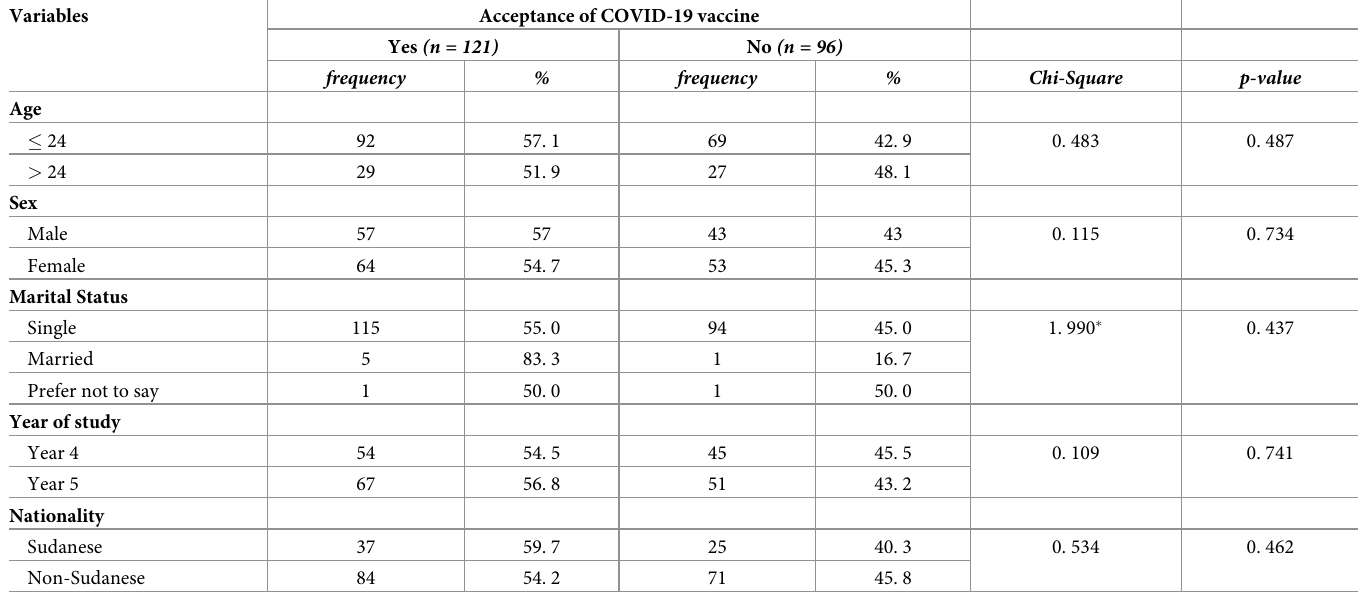
Table 3. Association of demographic characteristics with COVID-19 vaccine acceptance and hesitancy among medical students at IUA, Khartoum, Sudan, 2021 (n =